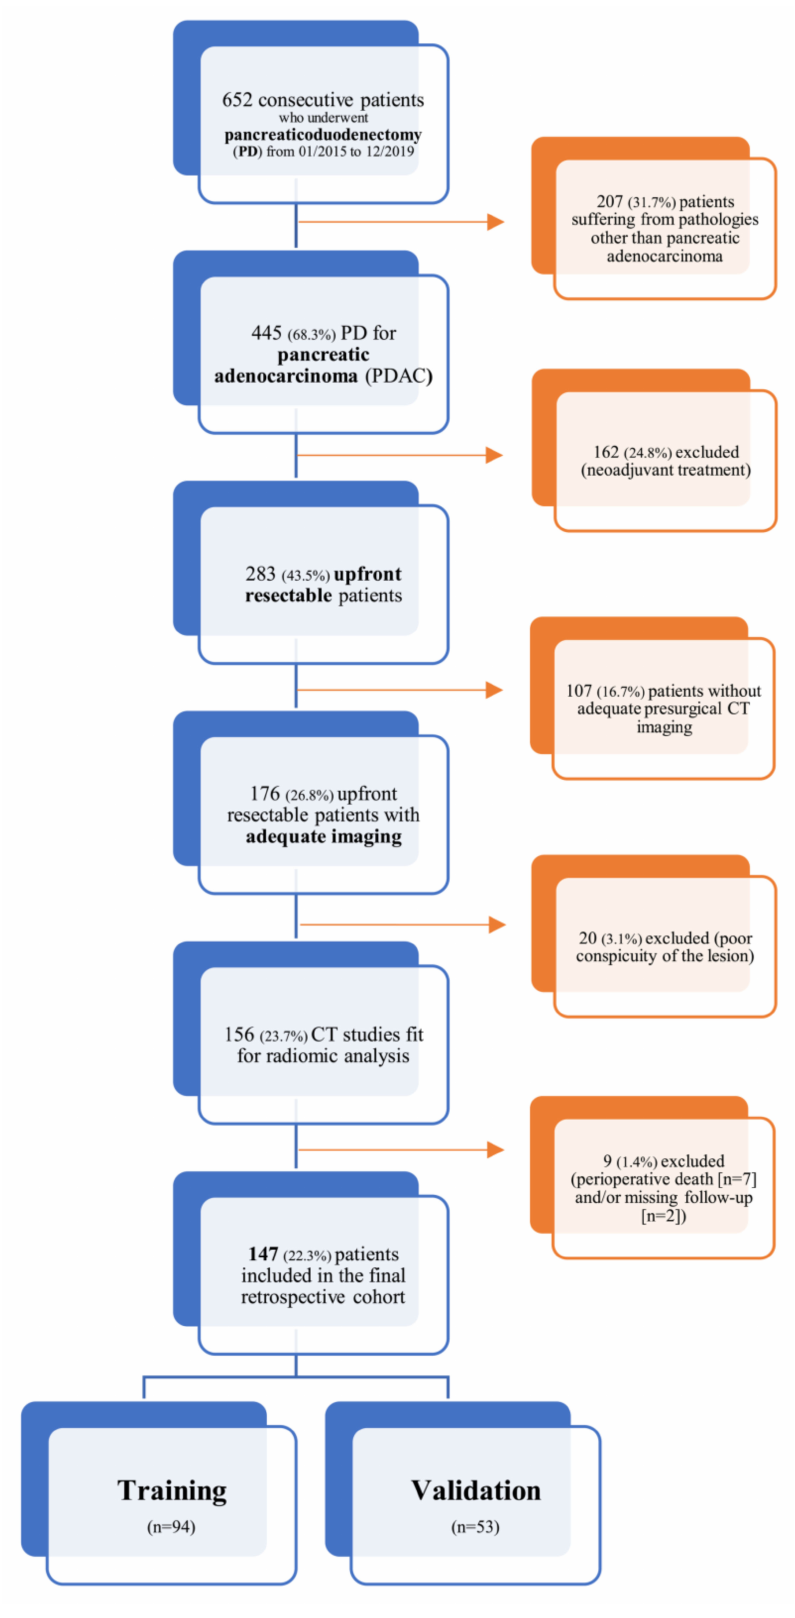
Figure 1. Inclusion and exclusion criteria